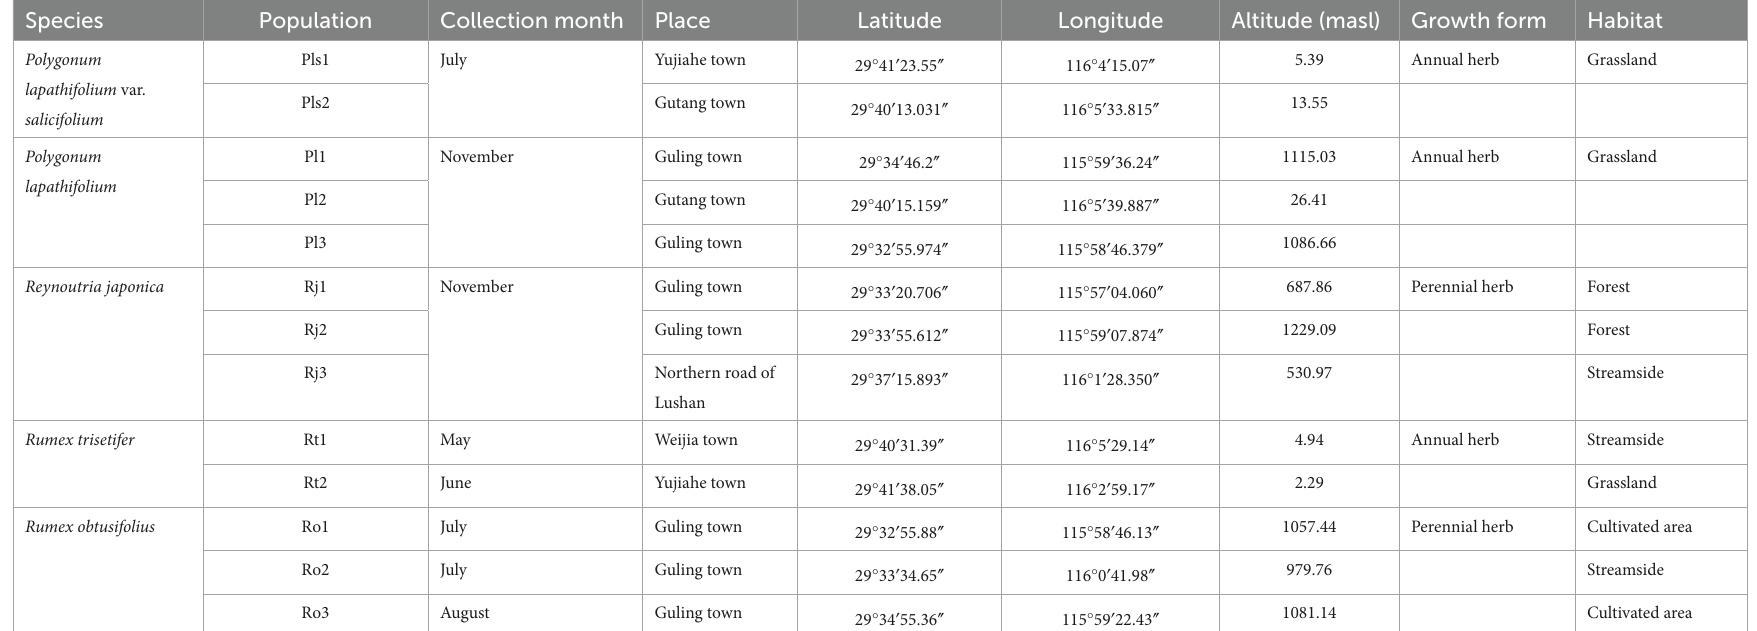
TABLE 1 Location and other details of the study